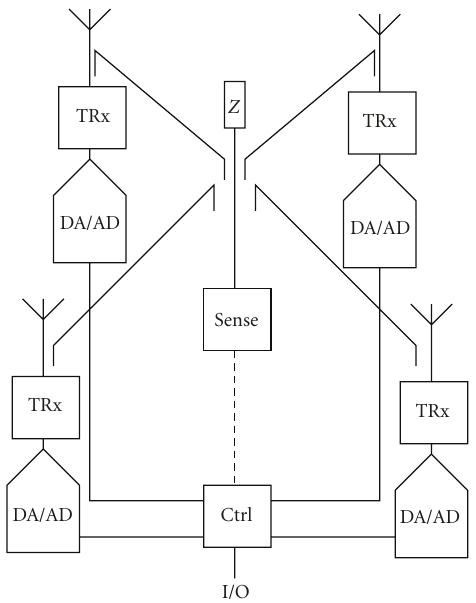
Figure 3: A central, nonradiative reference sensor element coupled to four radiative array transceiver elements.